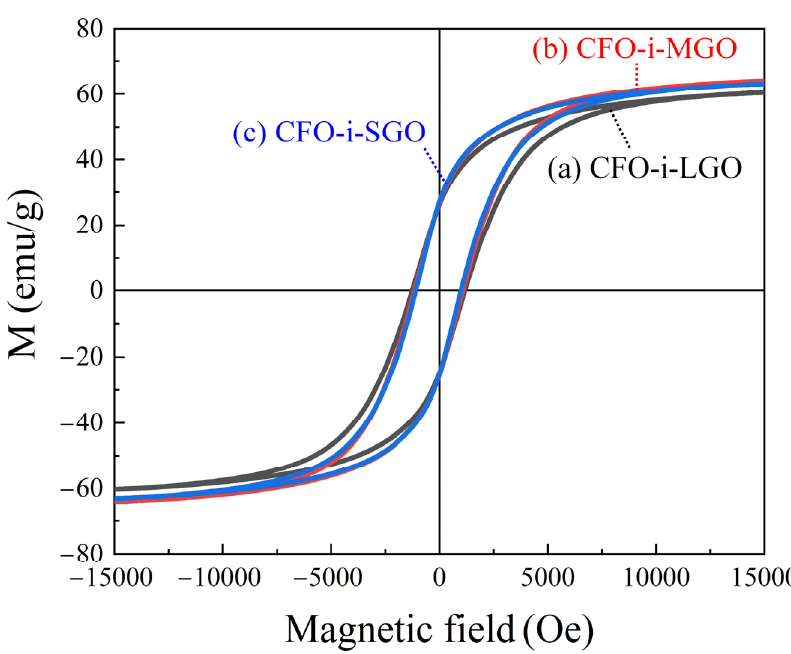
Figure 6. M-H hysteretic curves of the 2D magnetostrictive fillers of ( a ) CFO-i-LGO, ( b ) CFO-i-MGO, and ( c ) CFO-i-SGO.